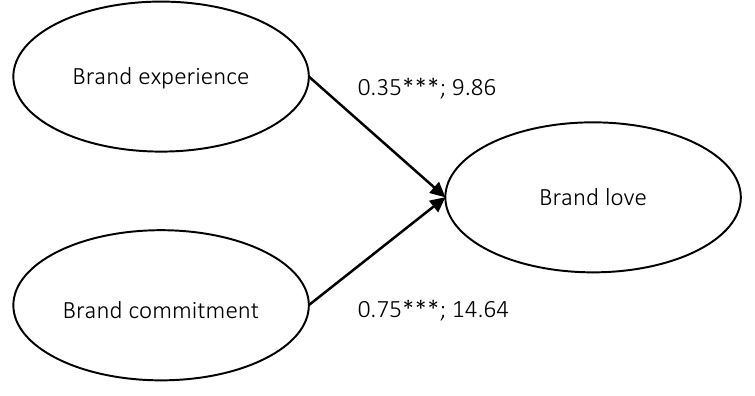
Figure 2. Structural model (factor loadings and t -values)